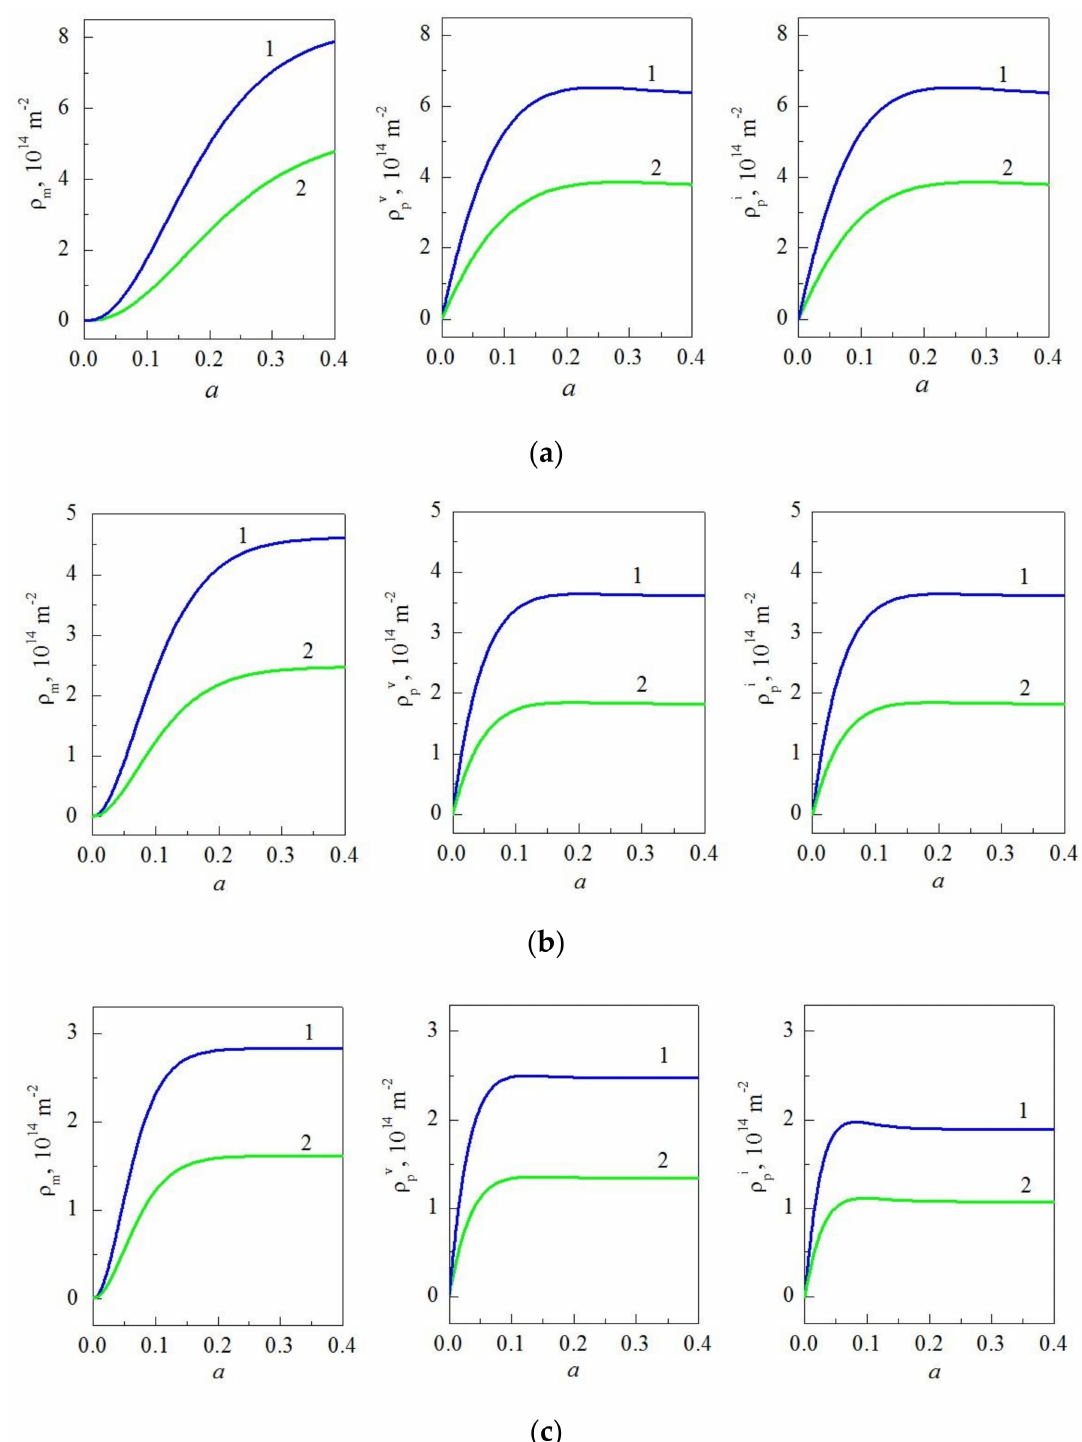
Figure 1. Dependencies of the density of shear-forming dislocations, dislocation density in the prismatic loops of vacancy and interstitial types from deformation. Diameter of particles ( δ ), nm: 1–10, 2–20; distance between particles ( Λ p ), nm: 1–100, 2–200; ( a ) temperature: 293 K, ( b ) temperature: 393 K and ( c ) temperature: 493